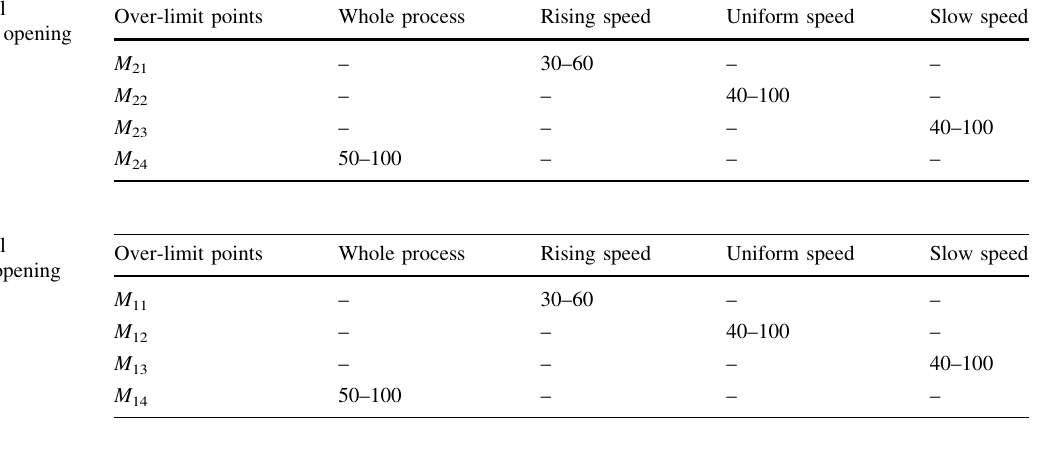
Table 10 Rules for local resistance increasing of closing door